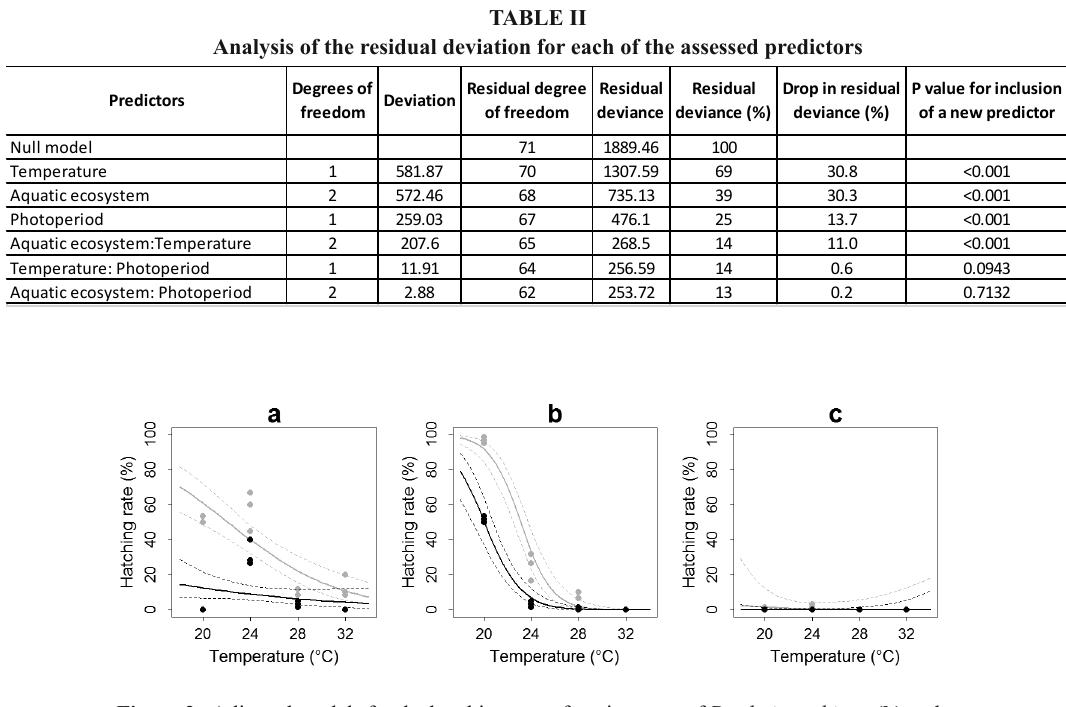
Figure 2 - Adjusted models for the hatching rate of resting eggs of Daphnia ambigua (b) and Daphnia laevis ( a and c ) in each environment, according to the treatments (grey line: light and black line: dark). The dotted lines represent the reliability intervals. Pampulha lake (a) , Nado lake (b) and Jacaré lake (c) .